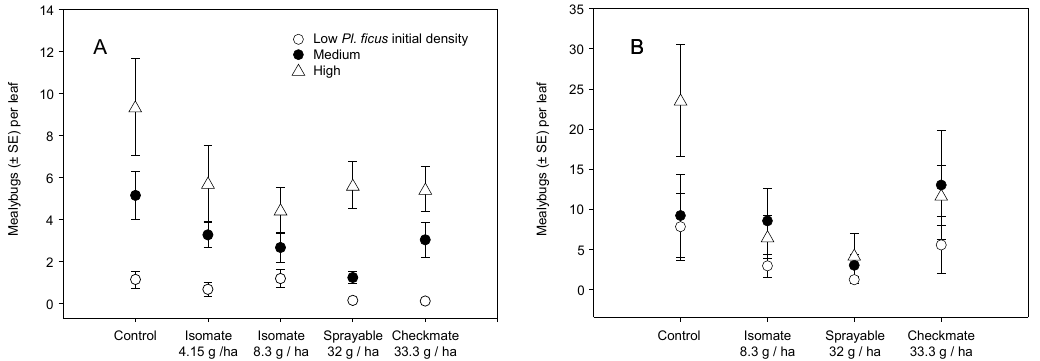
Figure 7. Vines were categorized as having an initial (April-May) low, medium, or high Pl. ficus population density and then compared for relative increases in ( A ) 2004 with plots treated with no MD, Isomate (4.15 g / ha and 8.3 g / ha), CheckMate Flowable (32 g / ha), or CheckMate dispensers (33.3 g / ha) and ( B ) 2005 with plots treated with no MD, Isomate (4.15 g / ha), CheckMate Flowable (24 g / ha), or CheckMate dispensers (33.3 g / ha).